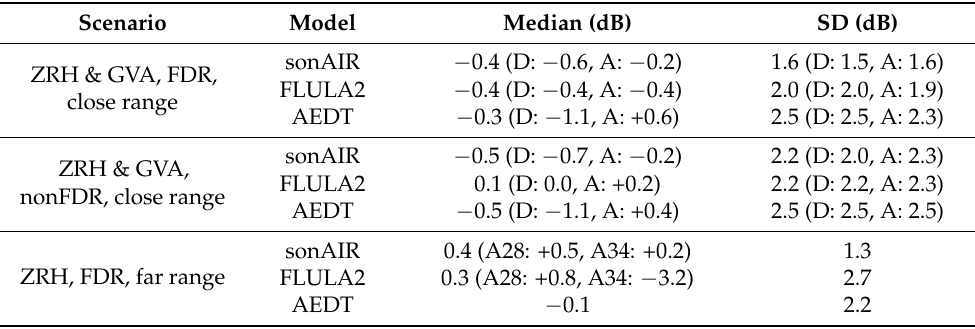
Table 4. Differences between simulation and measurements for all scenarios, in brackets separated into departures (D) and approaches (A).